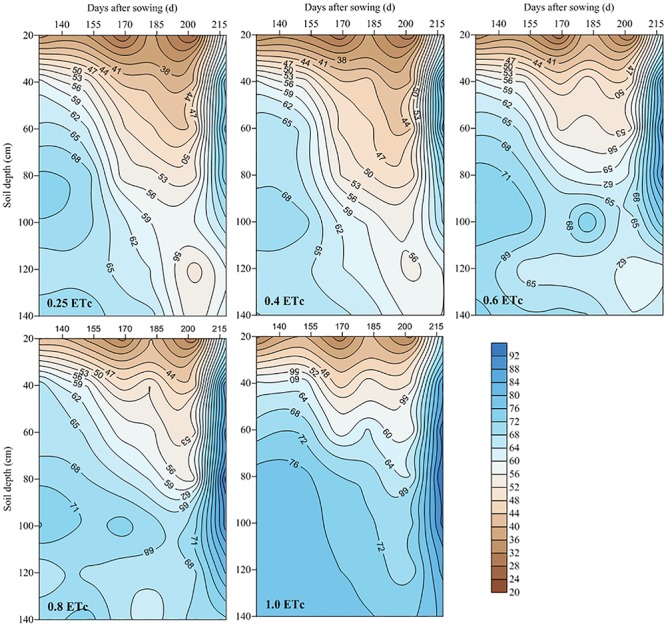
Temporal and spatial distribution of relative soil water content under different drip irrigation treatments (2017–2018). The 0.25, 0.4, 0.6, 0.8, and 1.0 ETc represents 25, 40, 60, 80, and 100% crop evapotranspiration, respectively.